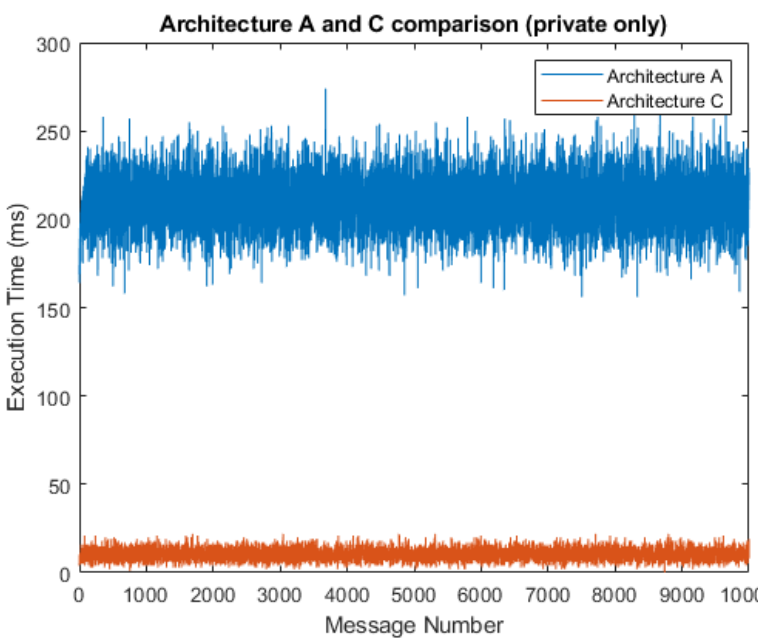
Figure 9. Comparison of architectures A and C (100% private